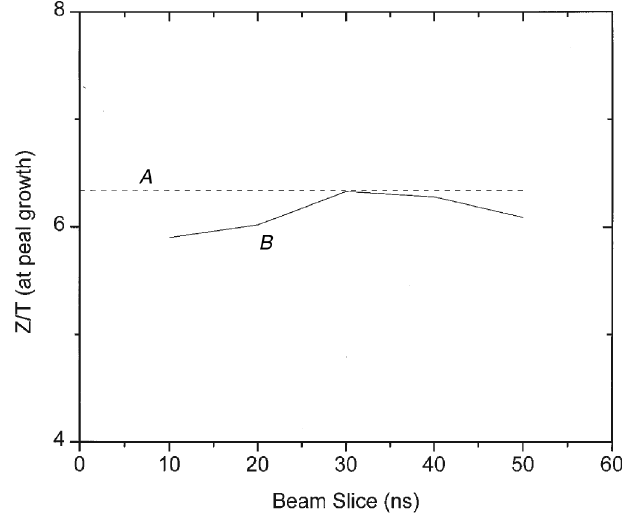
FIG. 2. For a Bennett conductivity profile, position of peak growth (or wave packet convection rate) from ( A ) dispersion analysis and ( B ) numerical integration of model